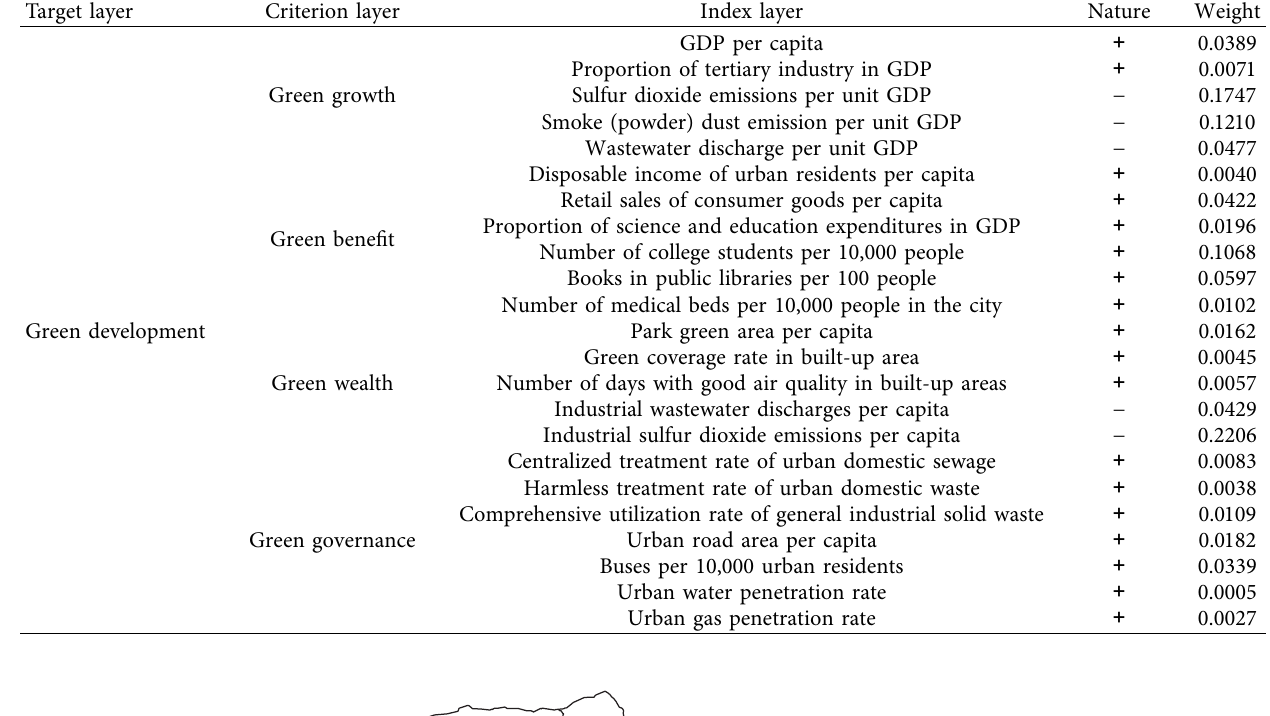
Table 1: Evaluation index system of green development.